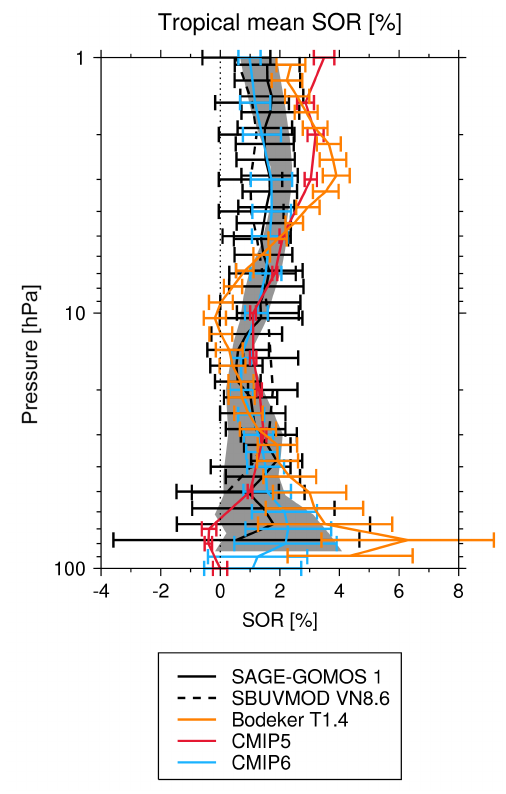
Figure 6. Vertical profiles of the tropical (30 ◦ S–30 ◦ N) average an- nual SOR per 130SFU (%). The range of the best estimates across the eight CCMI-1 models is shown in the grey shading. The lines show the best-estimate tropical mean annual SOR in the three cli- mate model ozone databases discussed in Sect. 3.2 and two satellite ozone datasets from Maycock et al. (2016) (SBUVMOD VN8.6 and SAGE-GOMOS 1). The whiskers denote 2.5–97.5% confidence in- tervals on the estimated